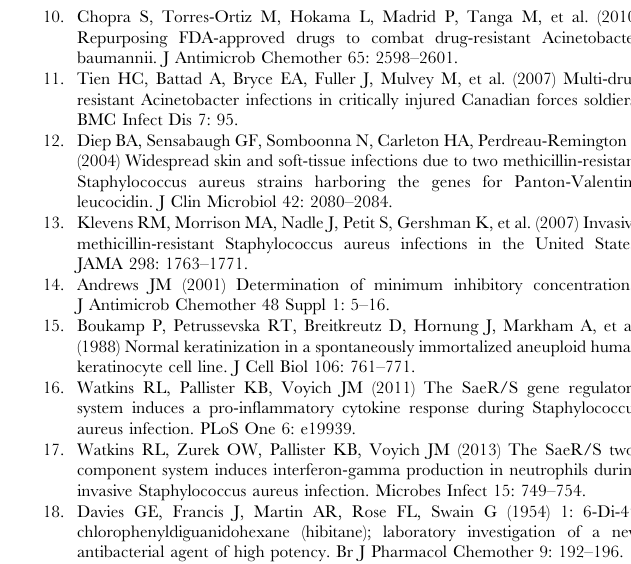
Figure S1 Cell viability. The number of viable cells was monitored throughout the absorbance assay. MRSA treated with Chlorhexidine (a) or THAM-3 F G (b) showed no significant reductions in CFUs. Figure S2 Cell leakage with control antibiotics. Ampicil- lin (a) and gentamicin (b) were tested to confirm the efficacy of the absorbance assay as a means to monitor potential membrane disruption. Significant increases in A 260 were not seen in either